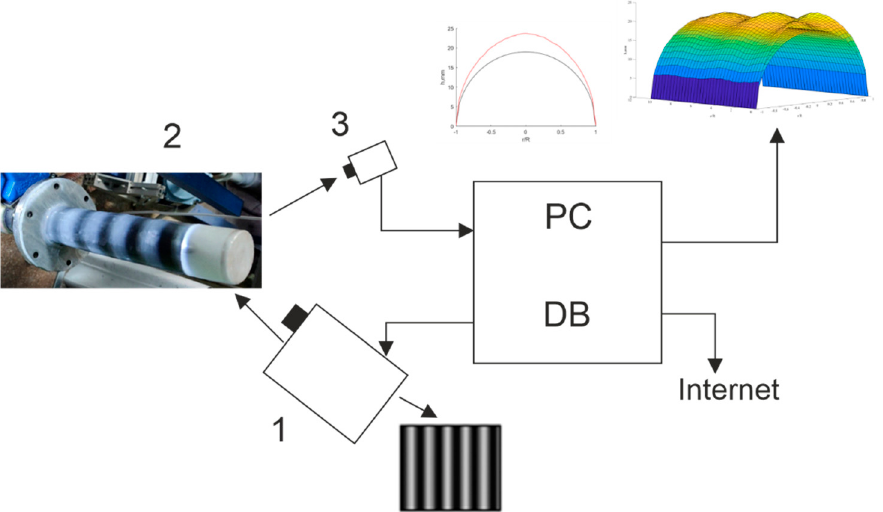
Figure 6. Functional diagram of the measuring complex of the phase triangulation method [63]. 1—